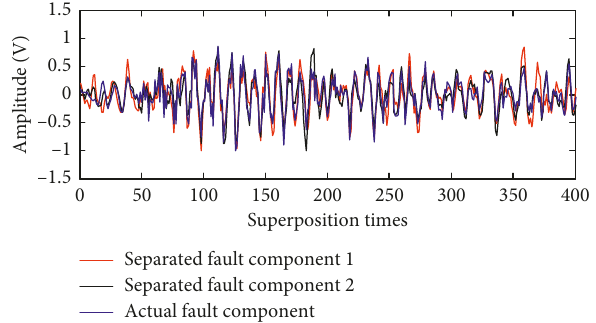
Figure 23: Separated and actual fault components of cylinder knocking.